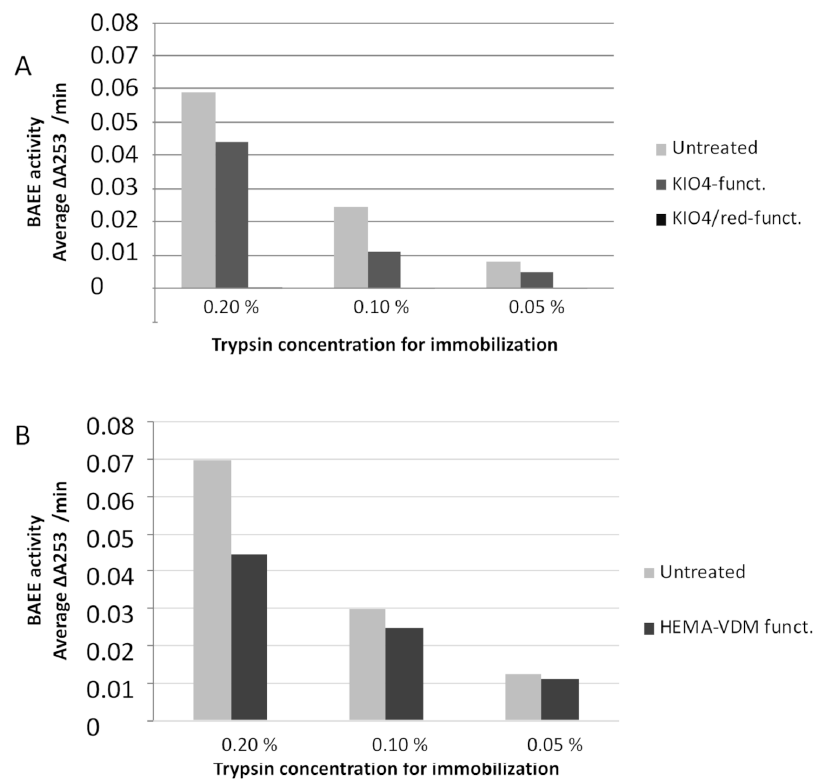
Figure 4. Indirect measurement of the trypsin activity. Activity in wash fraction as a function of immo- bilized trypsin concentration for ( A ) untreated paper, KIO 4 -functionalized paper and KIO 4 /reduced functionalized paper. Immobilization was carried out overnight using 10 µ L (0.05–0.2%)